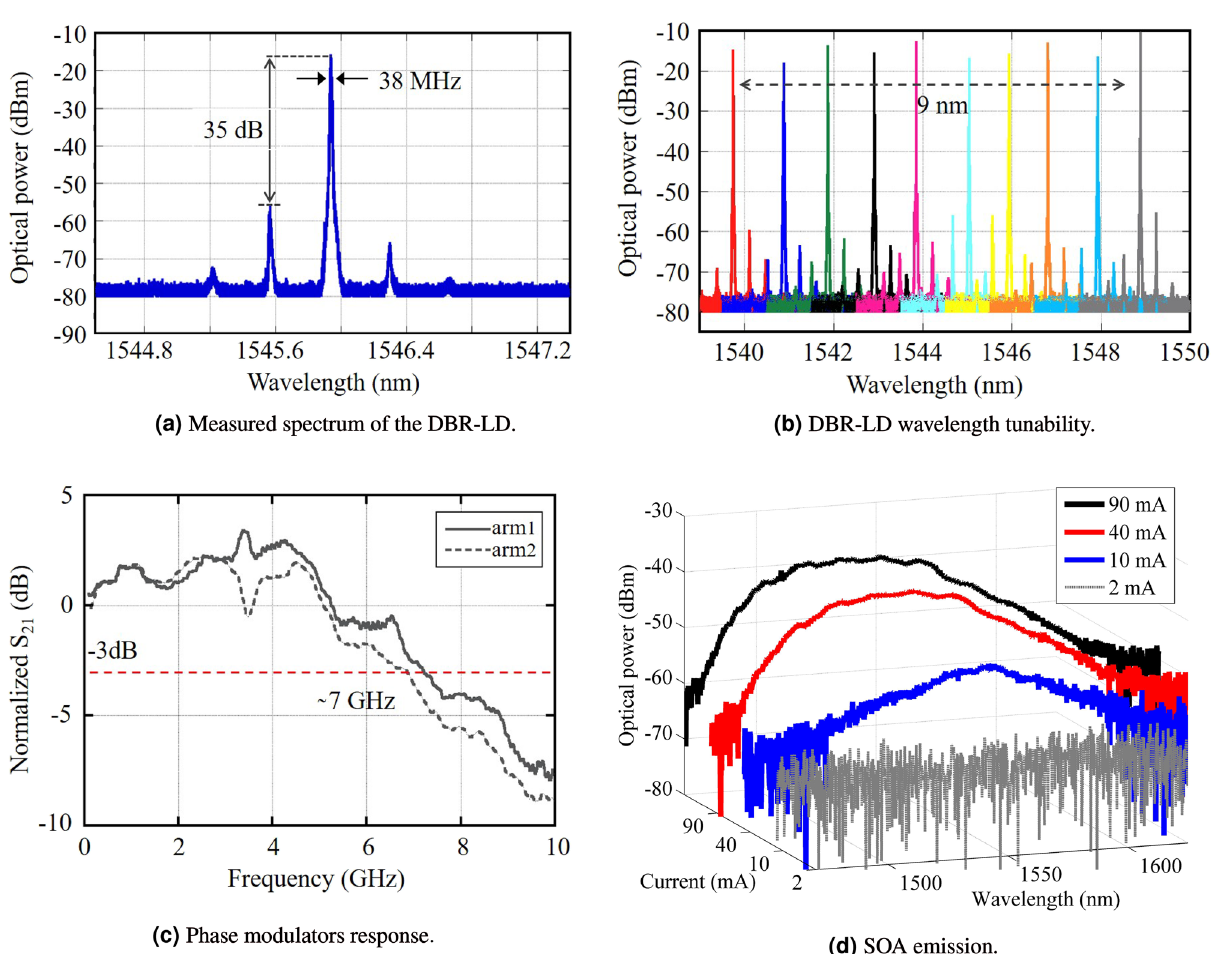
Figure 3. Characterization of the photonic integrated